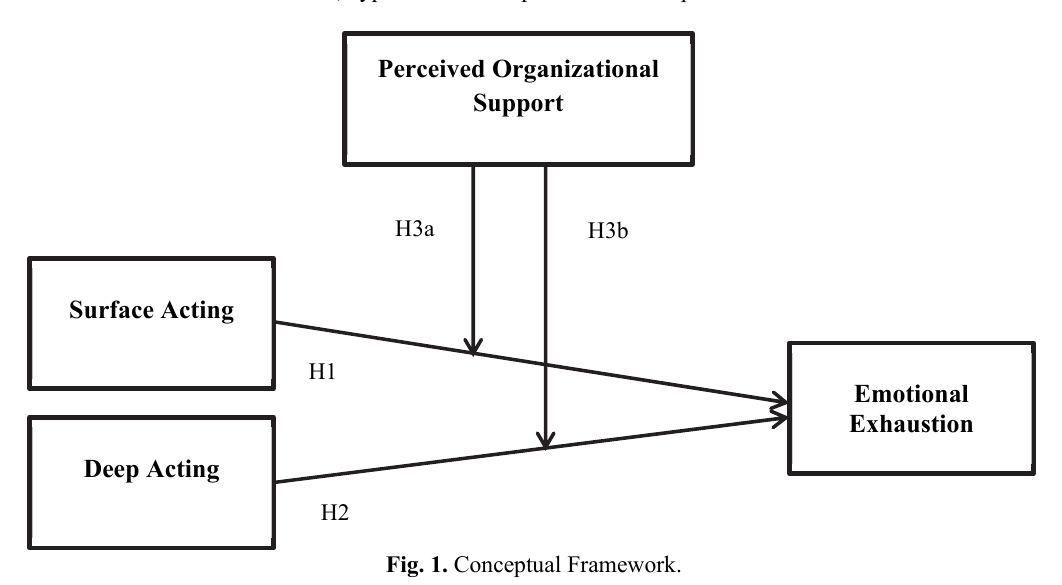
Fig. 1. Conceptual